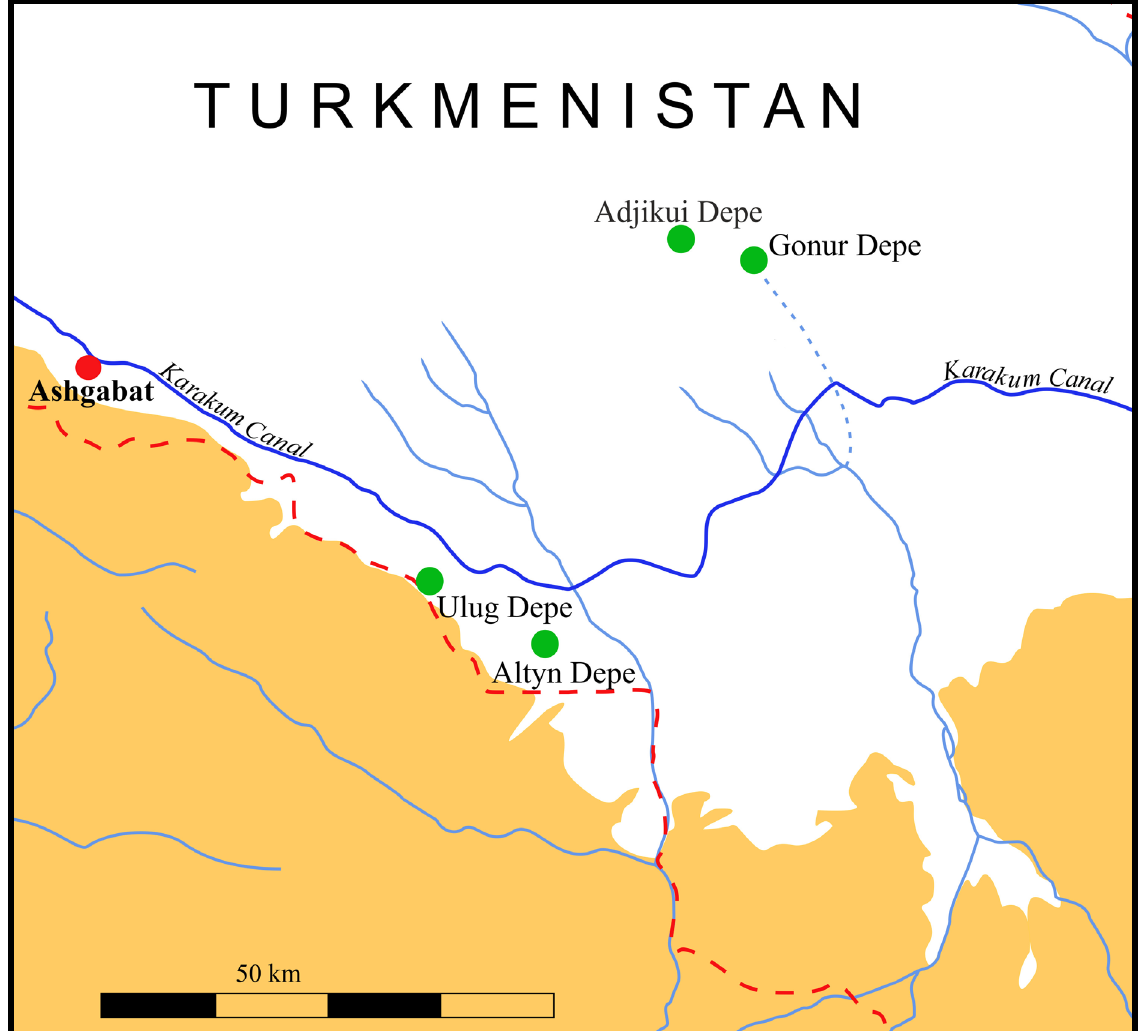
Figure 2. Map of the Bronze Age sites on the territory of Turkmenistan, the materials of which are used in the article. Scale bar is 200 km long, separated into five 50 km segments.